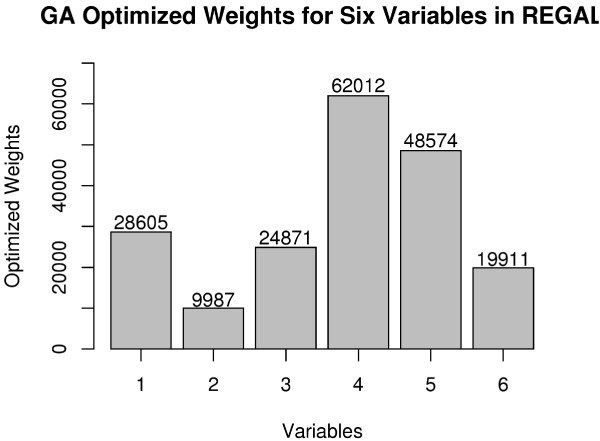
GA optimized weights for six variables in REGAL. We selected six variables and utilized the GA to optimize the weights for these variables. The greater the importance of a variable, the higher the value as shown here. Variables were abbreviated as follows: 1 = codon_transition, transition probability for codon pre- and post-edit; 2 = +1_nucleotide, nucleotide in +1 position relative to candidate C; 3 = hydrophobicity, likelihood that edit will yield a more hydrophobic amino acid than the unedited codon; 4 = amino_acid_transition, transition probability for amino acid pre- and post-edit; 5 = codon_position, position of the candidate edit site with respect to the codon (i.e. first, second or third position); and 6 = -1_nucleotide, nucleotide in the -1 position relative to candidate C.